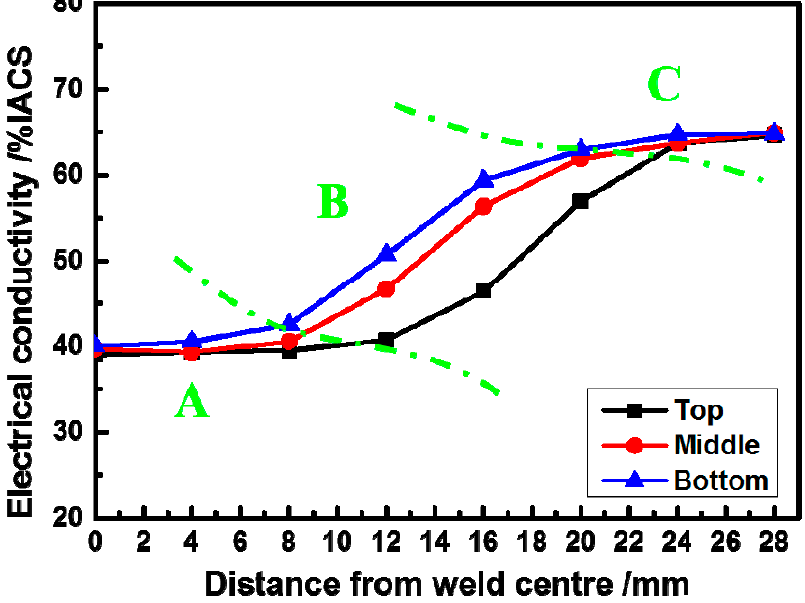
Figure 12. Electrical conductivity of FSW CuCrZr joints: A: nugget zone (NZ); B: transition zone: Thermo-mechanically affected zone (TMAZ) and heat affected zone (HAZ); and C: base metal (BM).